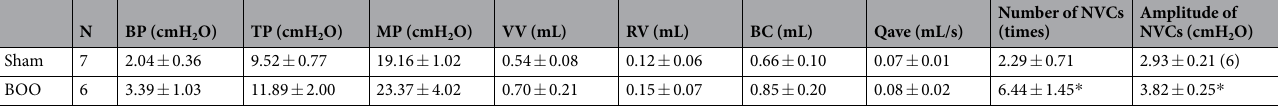
Table 1. CMG parameters in Sham and BOO groups at day 4 post-operatively. The values were expressed as mean ± SEM. * P < 0.05: significant difference from the Sham rats (unpaired Student’s t -test). The number in a parenthesis indicates the number of Sham rats that were observed the NVCs. N = number of animals; BP = basal pressure; TP = threshold pressure; MP = maximm pressure during micturition; VV = voided volume; RV = residual volume; BC = bladder capacity; Qave = mean uroflow rate; NVCs = non-voiding contractions.